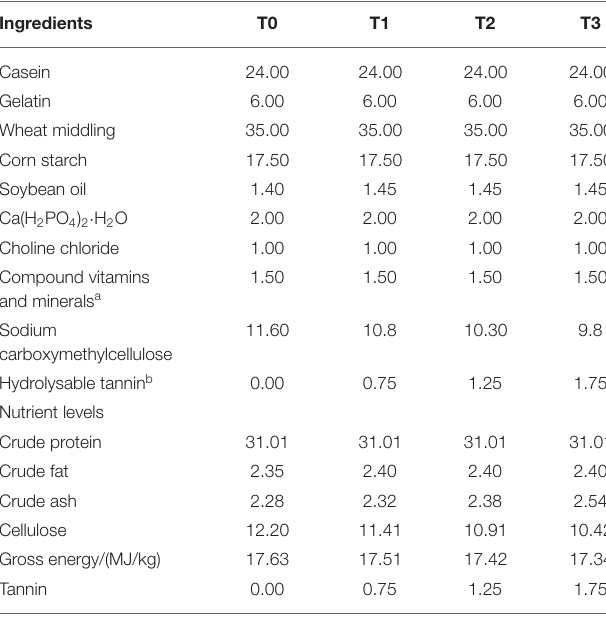
TABLE 1 | Composition and nutrient levels of diets (dry basis)